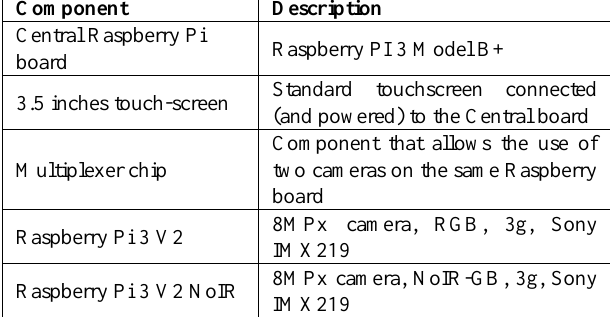
Table 1. Components of the Raspberry-based device